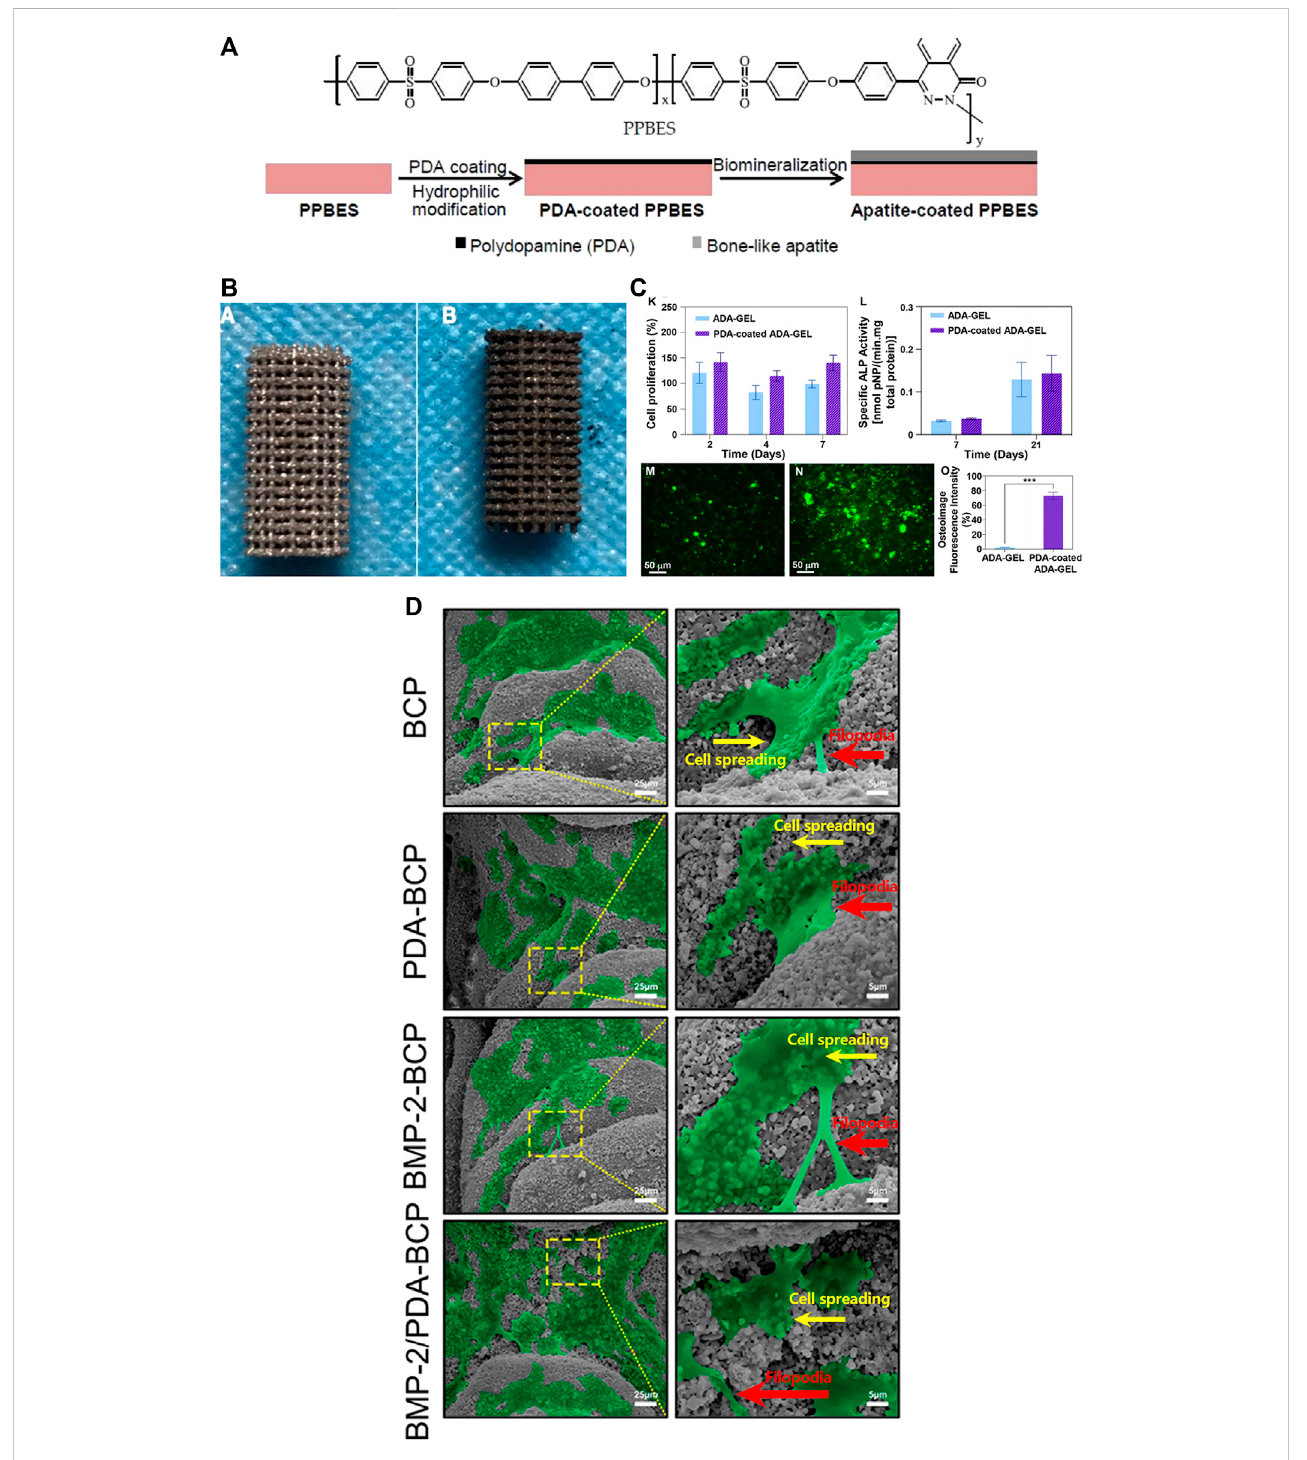
FIGURE 1 (A) The structure of Copoly (phthalazinone biphenyl ether sulfone) (PPBES) and the dopamine polymerization on the PPBES, and fi nally apatite biomineralization on the surface. [reproduced content is open access- Attribution 4.0 International (CC BY 4.0)] (Liu et al., 2018). (B) The image of the 3D- printed porous titanium (3D PPT) (a), and the PDA coating on 3D-printed porous titanium (PDA-3D PPT) (b). (reproduced content is open access- Attribution 4.0 International (CC BY 4.0)) (Zhong et al., 2020). (C) The proliferation of the MG-63 osteoblast-like cells on the ADA-GEL, and PDA-coated ADA-GEL scaffolds atthe2, 4,7 days.Althoughtheproliferation ofcoatedscaffolds increased, thisincrease wasnotsigni fi cant(K),TheALPactivityoftheADA-GEL,and PDA-coatedADA-GELscaffoldsatthe7,and21 days.AlthoughtheALPactivityofcoatedscaffoldsincreased,thisincreasewasnotsigni fi cant(L).(reproduced contentisopenaccess-Attribution4.0International(CCBY4.0))(Ghorbanietal.,2022). (D) OsteoimagemineralizationoftheuncoatedADA-GELscaffold(M) and PDA-coated ADA-GEL scaffold (N). The result of the quantitive osteoimage mineralization. The result was signi fi cant (*** p < .001) (reproduced content